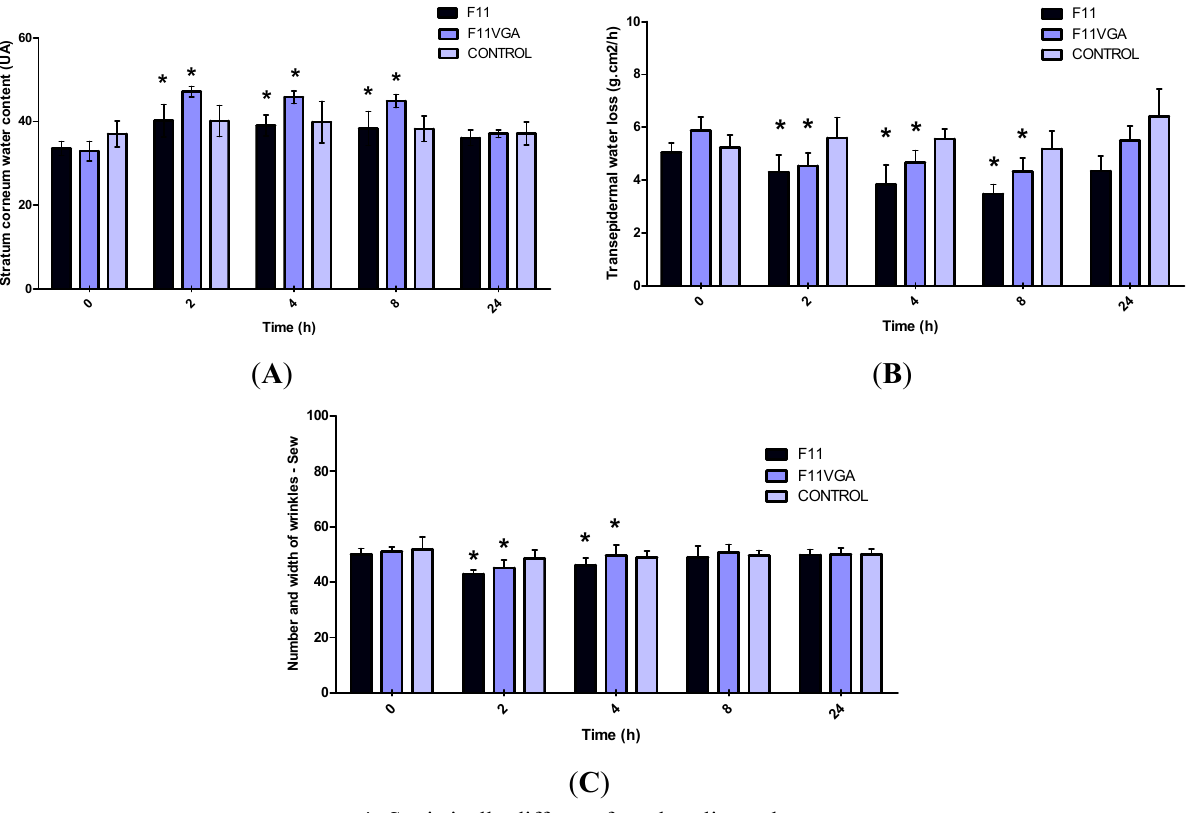
Figure 1. Mean and confidence interval 95% (CI95%) achieved after a single application of studied formulations for the parameters: stratum corneum water content ( A ), transepidermal water loss ( B ) and number and width of wrinkles—Sew ( C ), evaluated on the forearms of the volunteers (N = 45 volunteers).